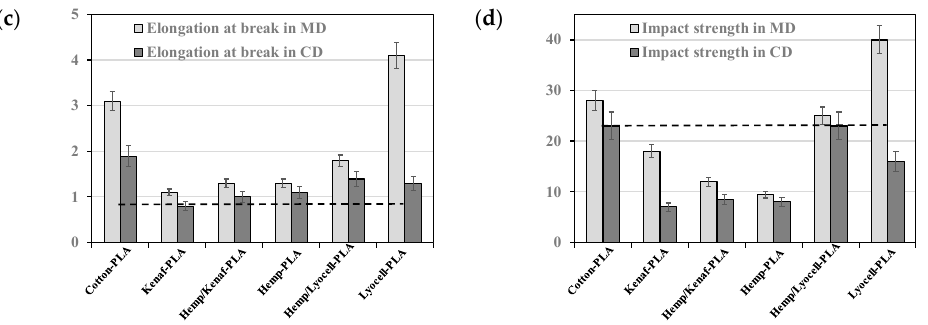
Figure 13. Mechanical properties: ( a ) Tensile strength, ( b )Young’s modulus, ( c ) elongation at break, and ( d ) Charpy impact strength of the composites and neat PLA (MD—machine direction; CD—cross direction; standard deviation are shown as error bars; the letter in the figures a, b, c, d, and e means that there are significant differences between the mean values measured in MD) [67], Reproduced with permission from Graupner N, Composites: Part A; published by Elsevier, 2009.